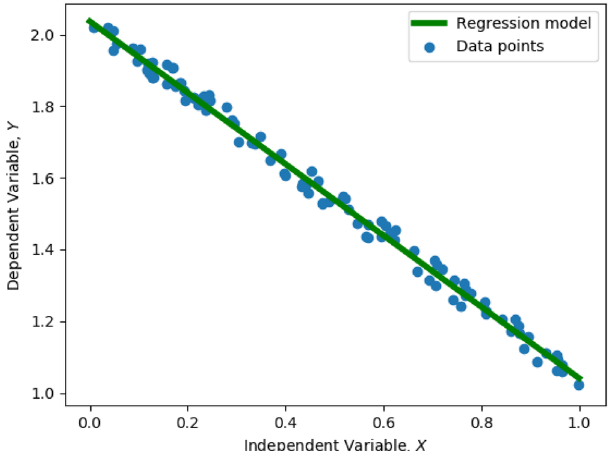
Figure 1. Fitting a linear regression model (green line) to data (blue